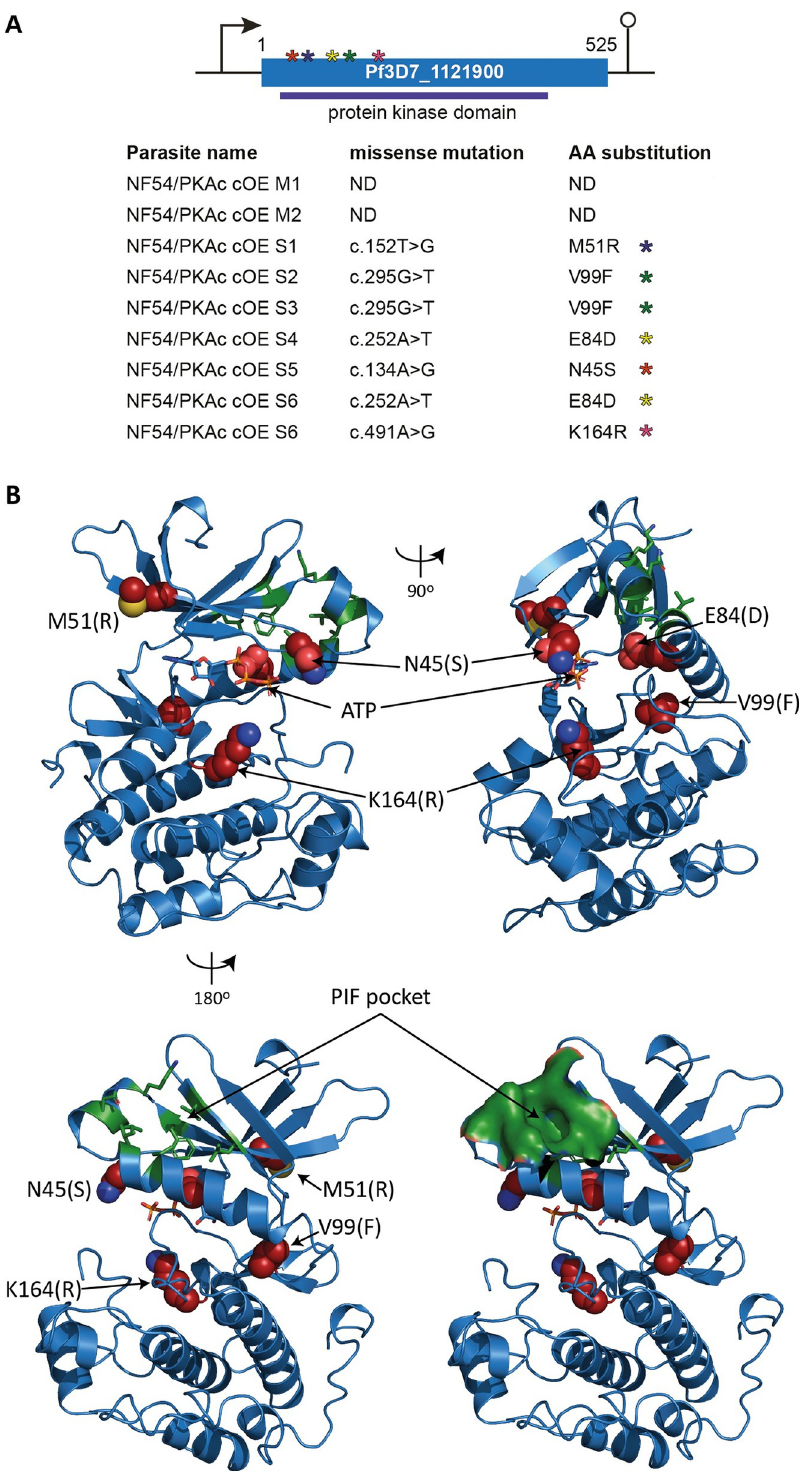
Fig 3. WGS reveals mutations in the Pf3D7_1121900/ pfpdk1 gene in 6 independently grown NF54/PKAc cOE survivor parasites. (A) Top: Schematic of the Pf3D7_1121900/ pfpdk1 gene. Asterisks indicate the approximate localisation of the 5 missense mutations identified in the 6 different NF54/PKAc cOE survivors. Bottom: Summary of the sequence information obtained from WGS of gDNA of the 2 NF54/PKAc cOE clones (M1, M2) and the